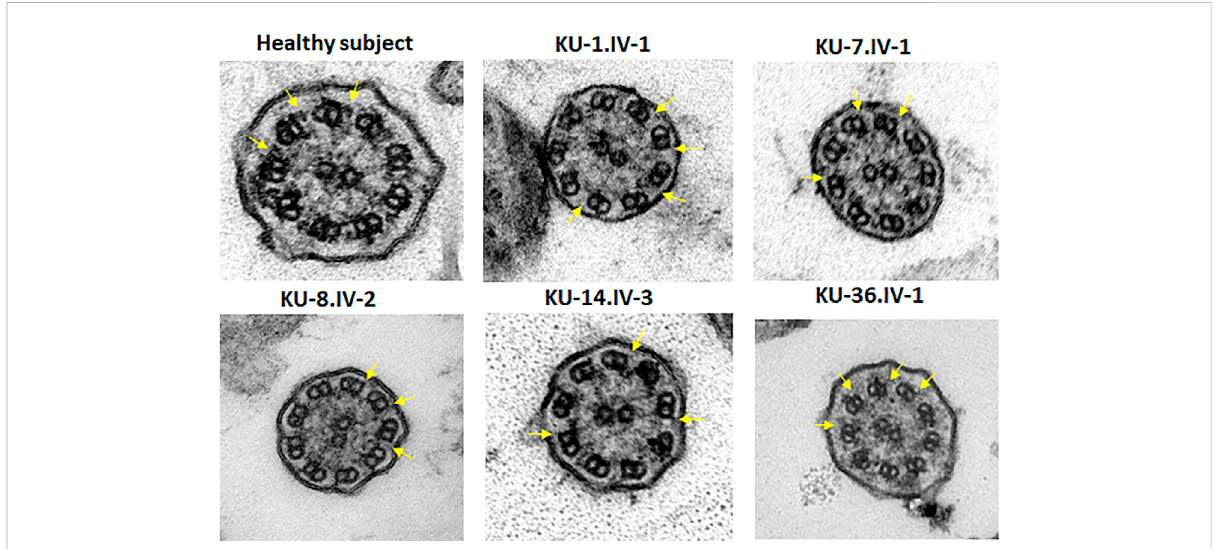
FIGURE 6 TEM sections of the ciliary axoneme for PCD individuals versus control. TEM results for ciliary axoneme of the ciliated epithelial cells of respiratory system indicate that the PCD patients have an absence of ODAs compared with control, which is mainly seen in patients with defects in genes encoding dynein arm components, consistent with their